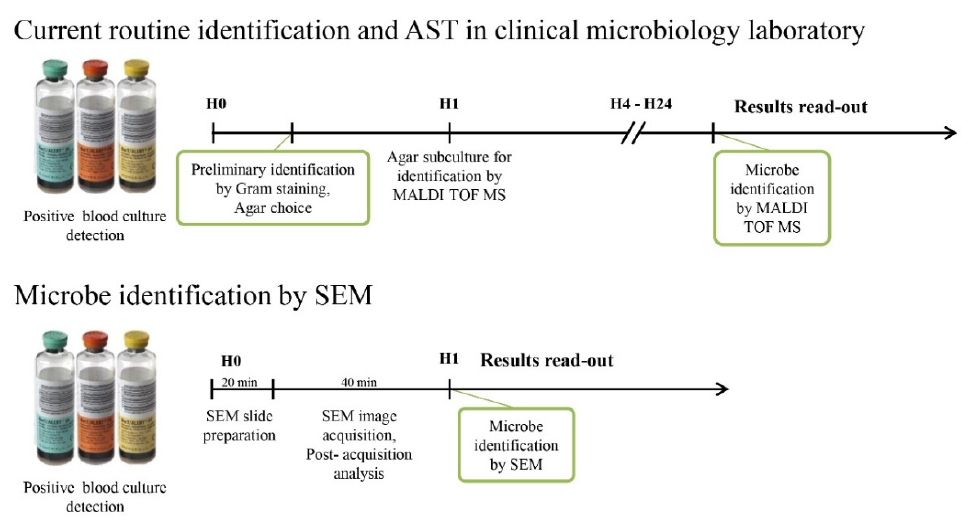
Figure 2. Timelines comparing routinely used methods for SEM identification. ( upper ) Gram staining starting from the positive blood culture, an essential step in redirecting the choice of the agar medium for the subculture. MALDI TOF MS identification is then applied to the colonies grown after 4–24 h of incubation. ( lower ) SEM identification starting from the positive blood culture through the identification of the microbe within one hour following the simple SEM strategy we developed.